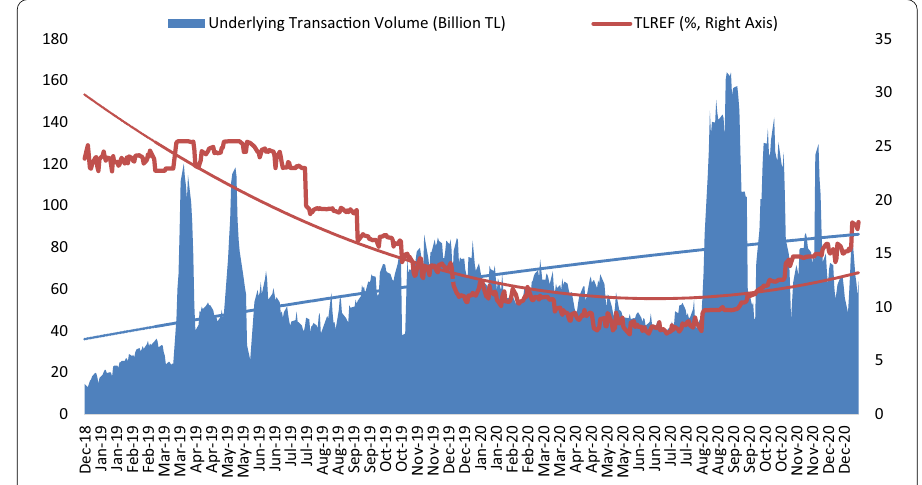
Fig. 1 The development of TLREF and underlying transaction volume. Source : BIST (2021a)